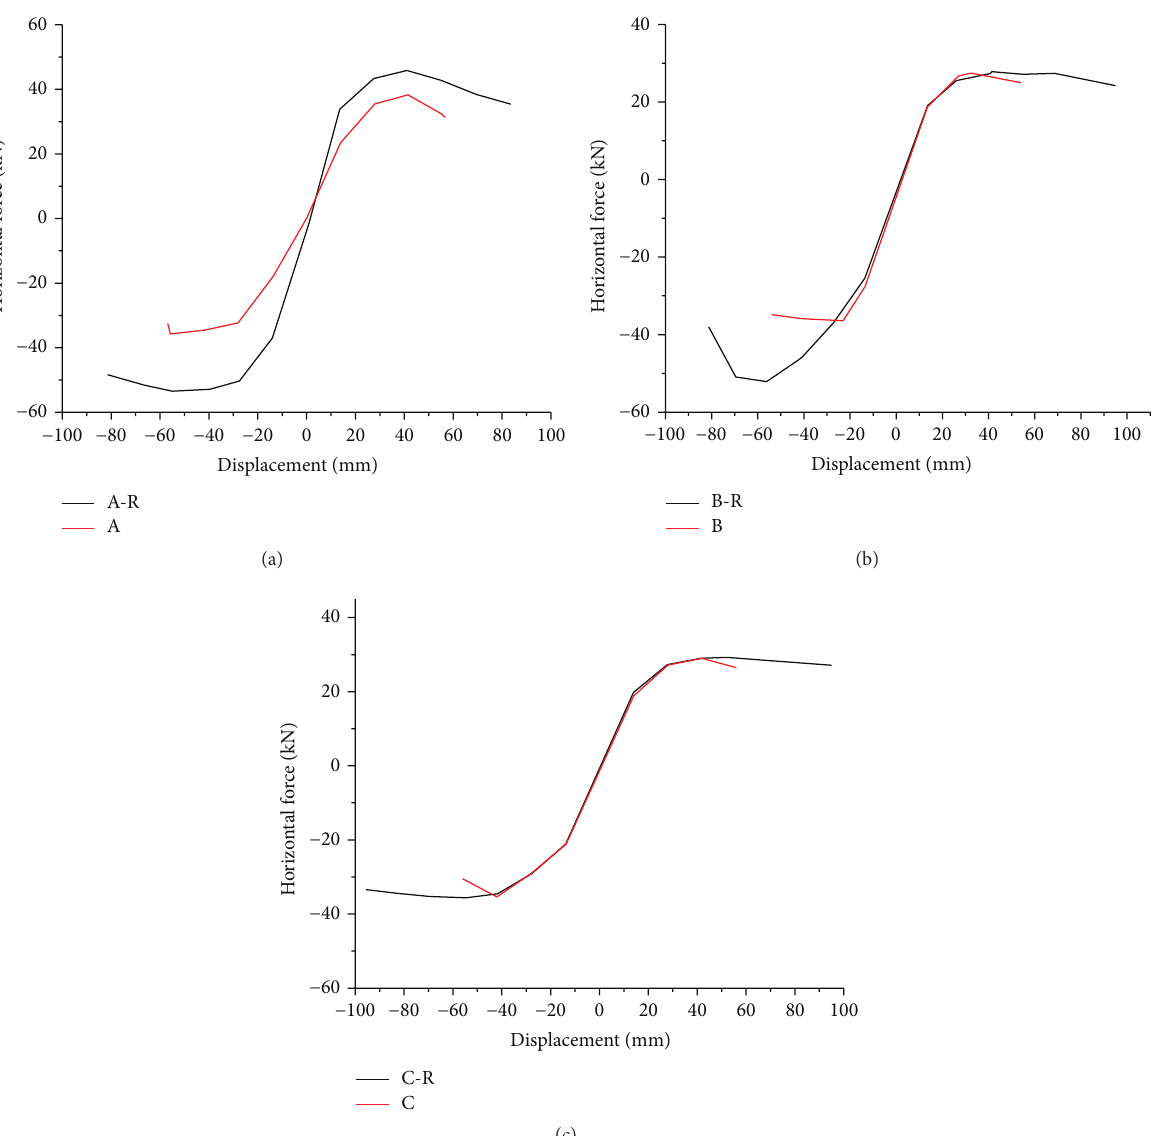
Figure 10: (a) Comparison of the specimen A skeleton curves. (b) Comparison of the specimen B skeleton curves. (c) Comparison of the specimen C skeleton